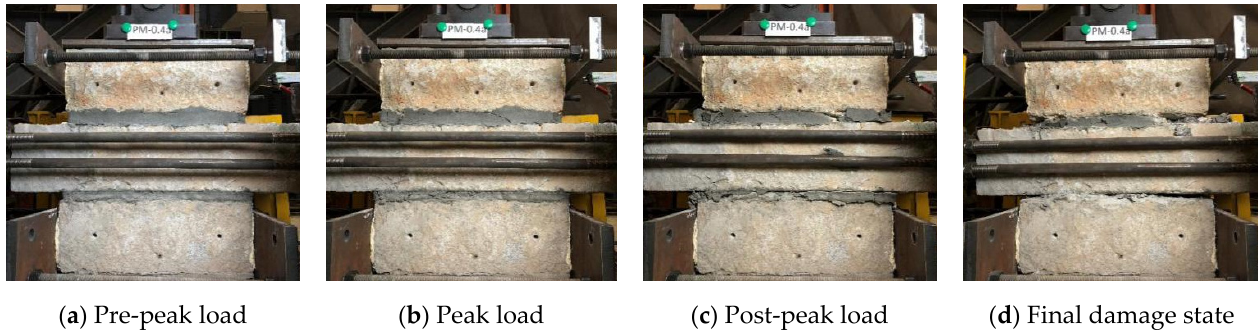
Figure 10. Typical failure process of M/PM specimens (PM-0.4): ( a ) Pre-peak load, ( b ) Peak load, ( c ) Post-peak load and ( d ) Final damage state.